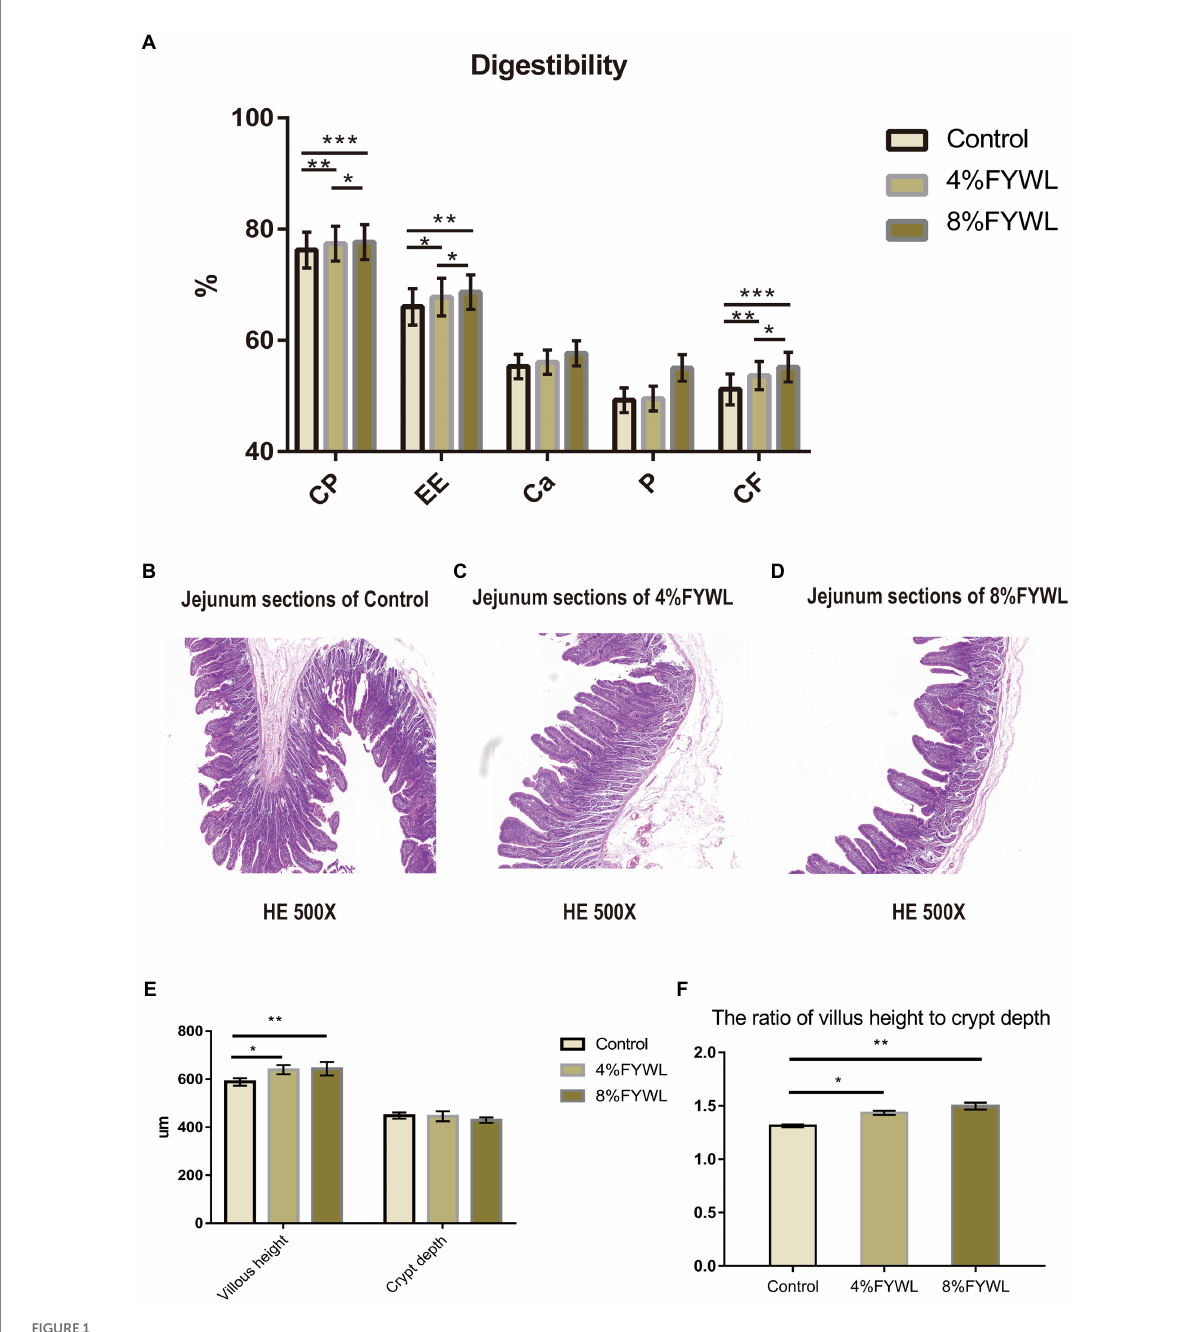
FIGURE 1 Nutrient digestibility and jejunal morphology. (A) Effect of fermented feed on the apparent digestibility of intestinal nutrients in fattening pigs, CP, crude protein; EE, ether extract; CF , crude fiber. (B–D) Pig intestine stained with H&E. (E,F) Effect of fermented feed on the length of intestinal villi and depth of crypt in finishing pigs. *, **, and *** represented significant differences ( p < 0.05), ( p < 0.01) and ( p < 0.001) from indicated control groups,